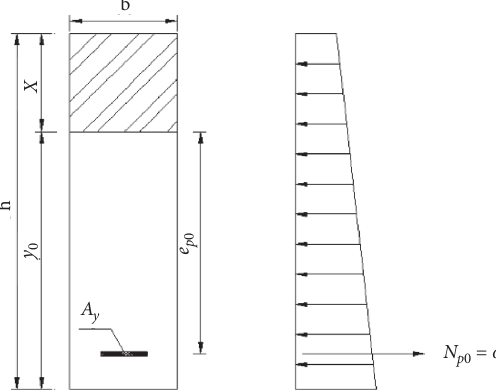
Figure 1: Diagram showing the simplified mechanical